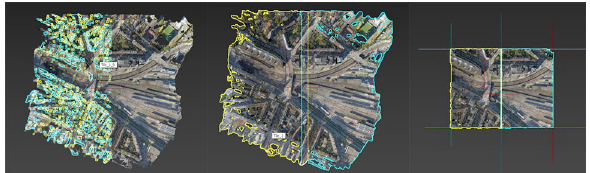
Figure 11. The mesh after import into the modelling software. From left to right. a few steps to obtain a clean model well bounded from the fragmented mesh with detached polygons.